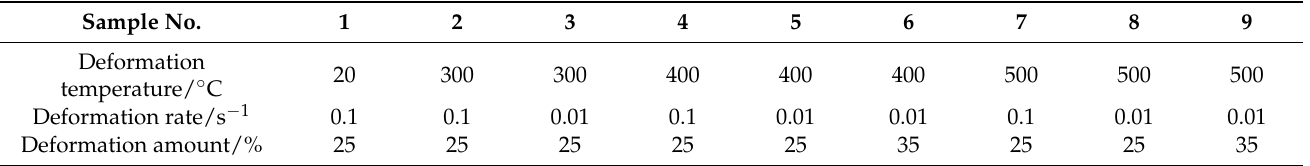
Table 1. Experiment program of H62 brass during